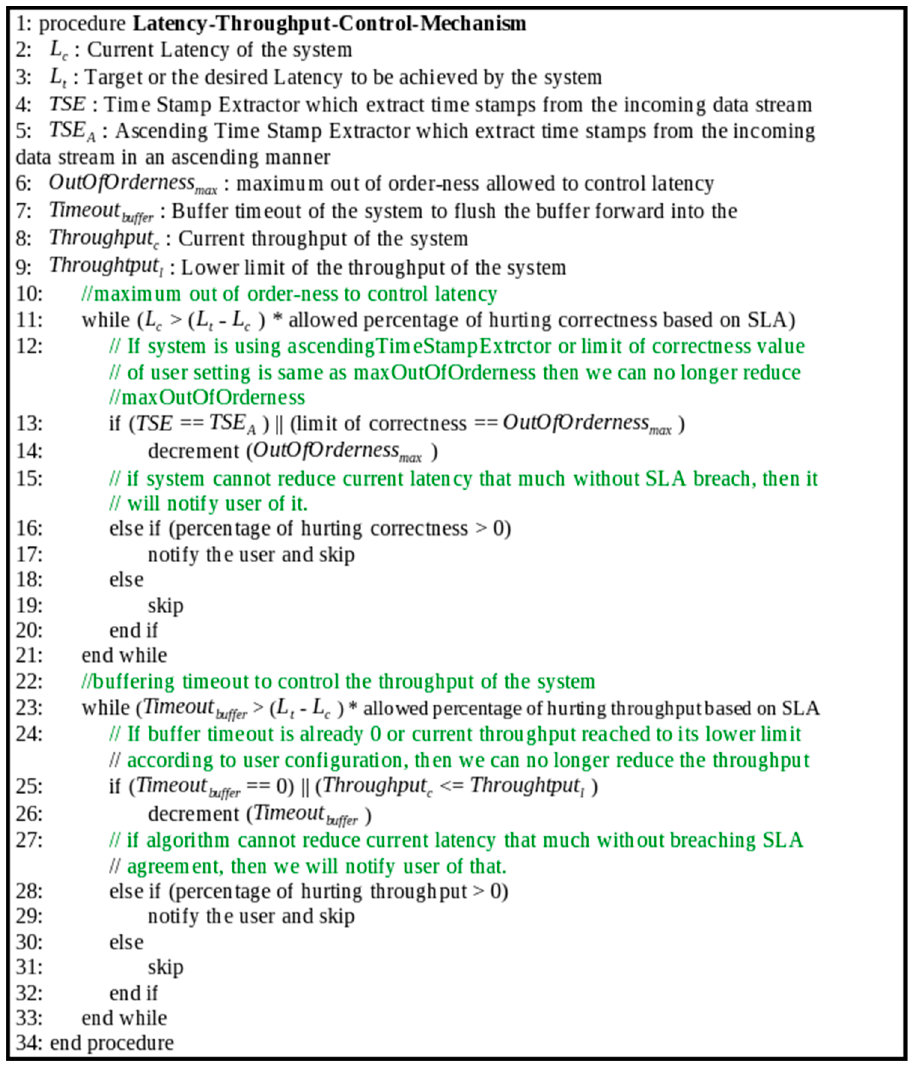
Figure 10. Dynamic latency control mechanism: Using the expected metrics, this mechanism controls the system’s latency based on the established SLA agreements.